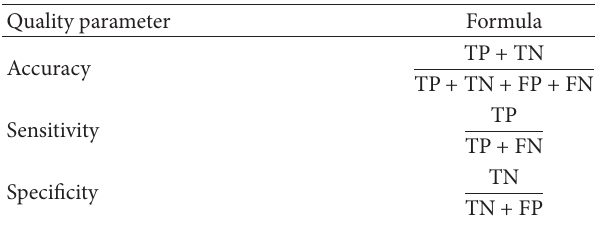
Table 4: Accuracy, sensitivity, and specificity